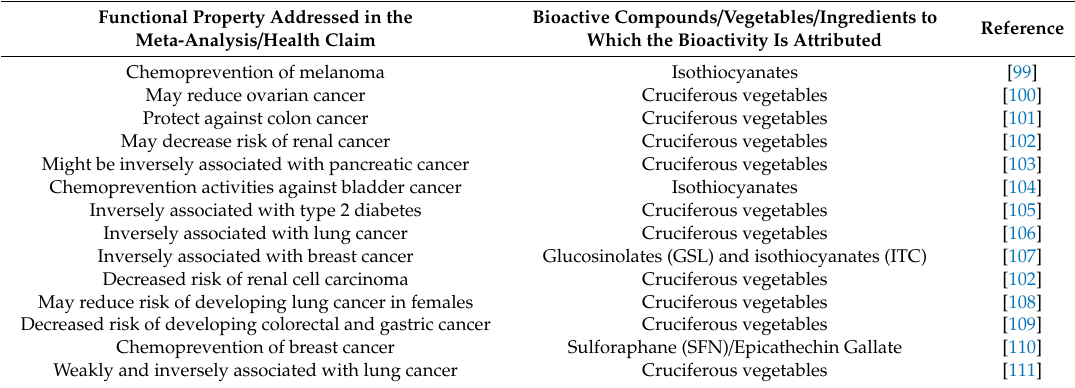
Table 1. Latest most relevant evidence for the association of CV / ITC / GLS intake and cancer preventive e ff